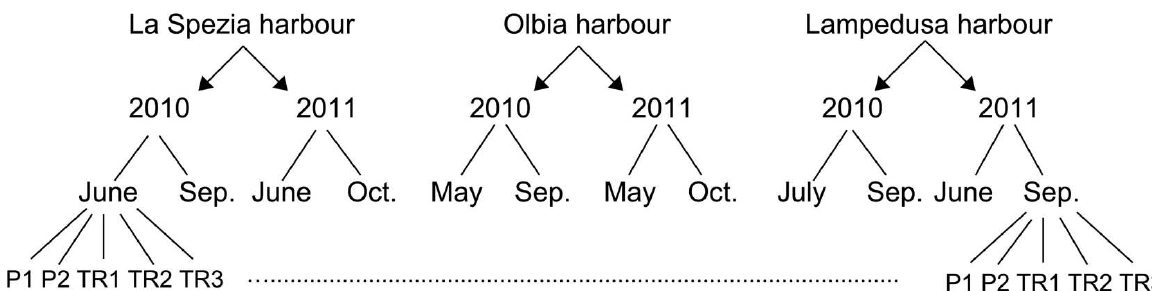
Fig. 2. – Experimental design: samples from La Spezia, Olbia and Lampedusa harbours were collected in 2010 and 2011, before and after the summer season. Five sampling sites were selected for each harbour (P1 and P2, residential moorings; TR1, TR2 and TR3, transit area